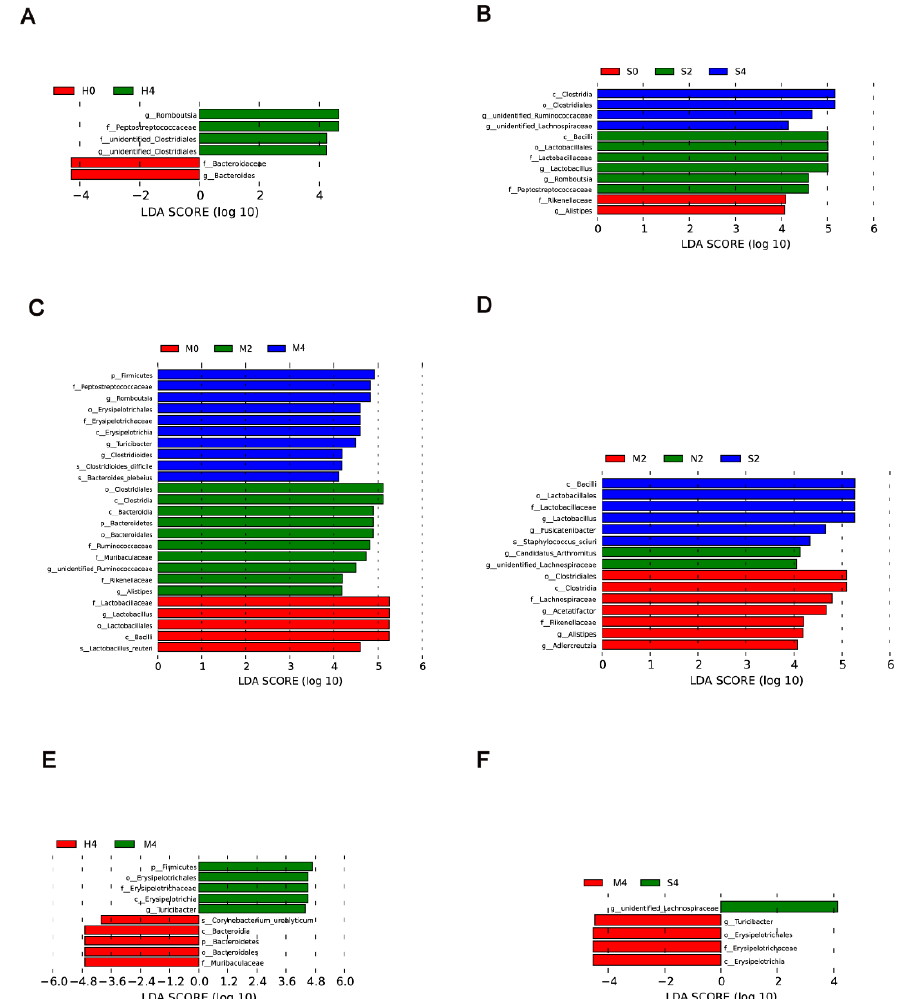
Figure 5. LDA of the microbial community variation. ( A – C ) A linear discriminant effect size (LEfSe) analysis was performed (alpha value ≥ 0.05, logarithmic LDA score threshold ≥ 2) at weeks 0, 2, and 4 in the Hyp group ( A ), HySu group ( B ), and MCT group ( C ). ( D ) LEfSe analysis was performed (alpha value ≥ 0.05, logarithmic LDA score threshold ≥ 2) on Nor, Hyp, HySu, and MCT groups at week 2. ( E ) LEfSe analysis was performed (alpha value ≥ 0.05, logarithmic LDA score threshold ≥ 2) on Nor, Hyp, and MCT at week 4. ( F ) LEfSe analysis was performed (alpha value ≥ 0.05, logarithmic LDA score threshold ≥ 2) on Nor, Hyp, and HySu at week 4. Nor (N): normoxia group; Hyp (H): hypoxia-induced group; HySu (S): hypoxia/Sugen 5416-induced group; MCT (M): MCT-induced group. 0, 2, and 4 represent the week of treatment.